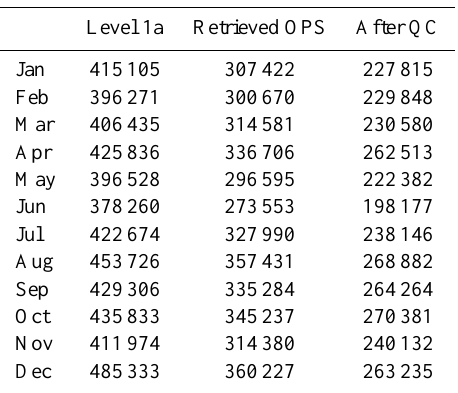
Table 1. Number of level 1a F3C data provided by UCAR/CDAAC (first column), number of bending angles profiles retrieved at WEGC (second column), and number of profiles that passed BAROCLIM quality control (last column). Numbers are shown for every month, adding up the data from August 2006 to December